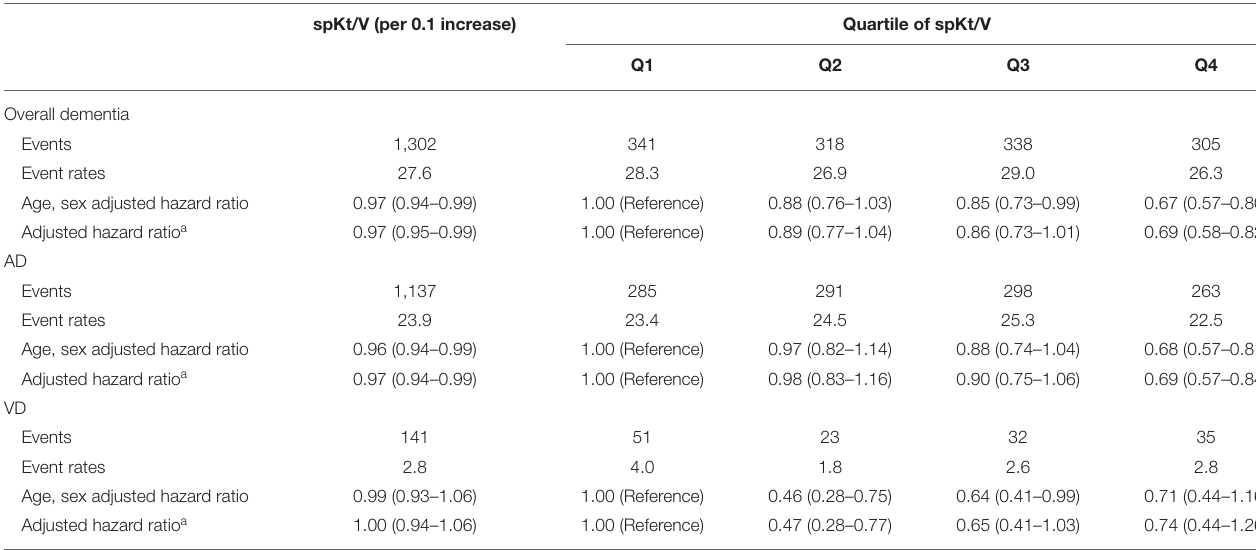
TABLE 2 | Risk of dementia according to quartile of